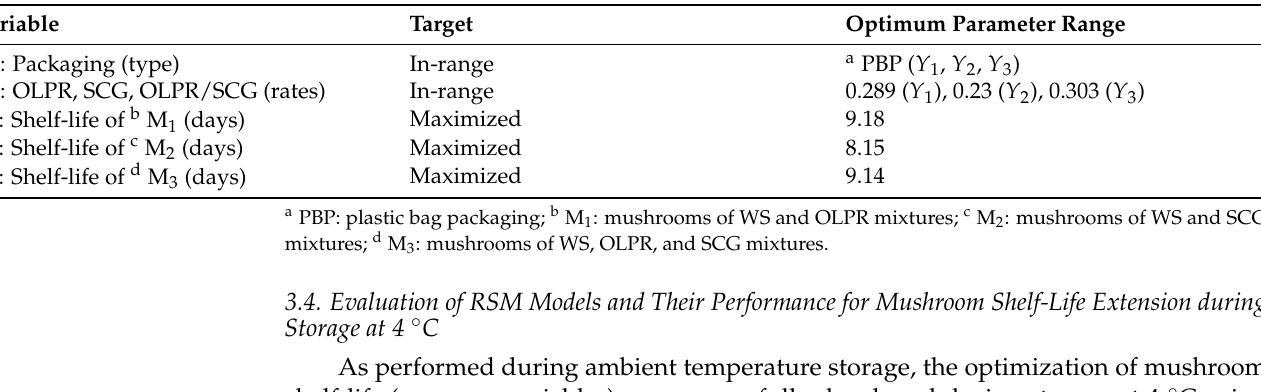
Table 4. Optimization results for extended shelf-life (days) of M 1 , M 2 , and M 3 stored at room temperature using the developed models.